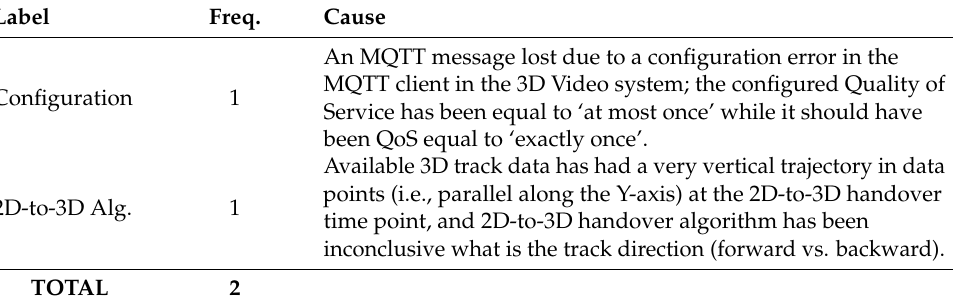
Table 5. Error causes of 3D